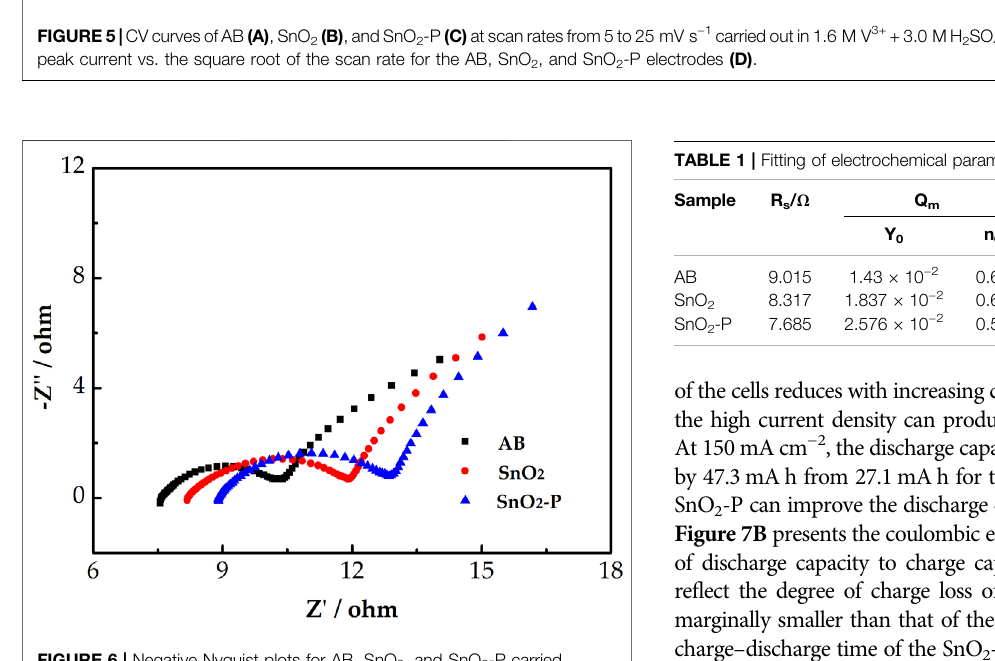
FIGURE 6 | Negative Nyquist plots for AB, SnO 2 , and SnO 2 -P carried out in 1.6 M V 3+ + 3.0 M H 2 SO 4 electrolyte and the simpli fi ed electrical equivalent circuit fi tting.